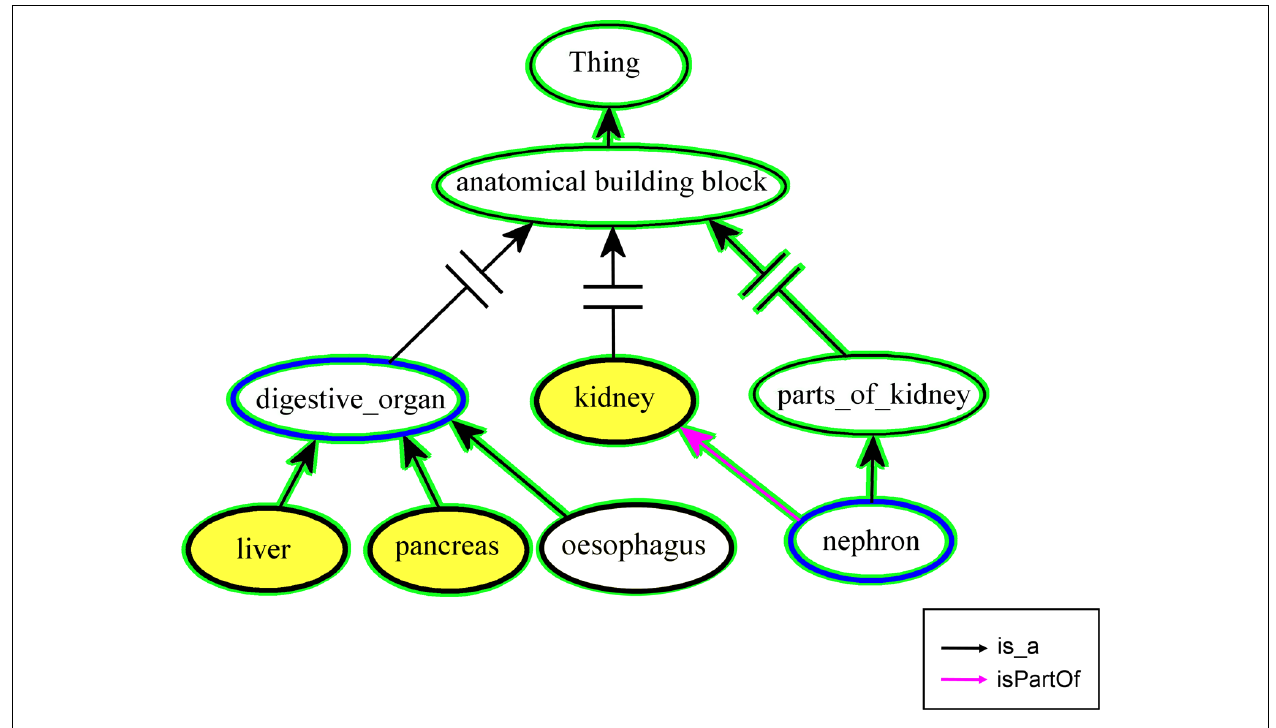
FIGURE 4 | Mapping entities to a predefined list. The nodes with the blue border represent the start nodes for the functions “findUpstreamInSet” and “findDownstreamInSet,” respectively.The nodes and edges marked with a green background shape are processed during the mapping.The